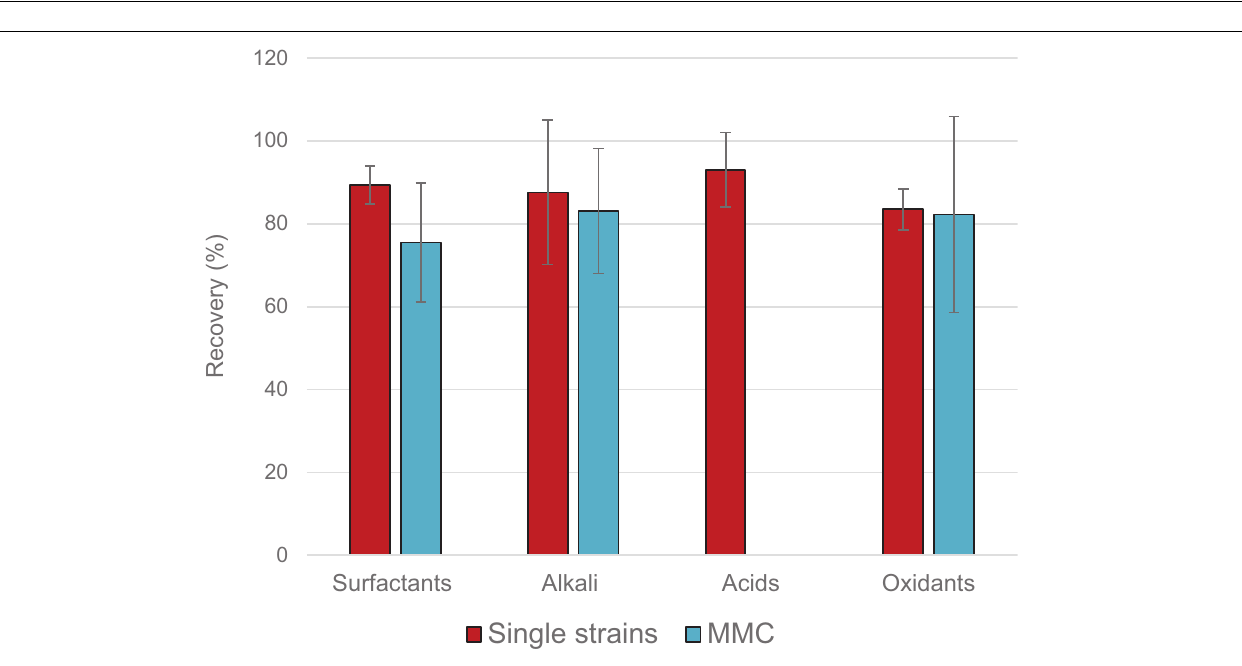
FIGURE 5 | Mean recovery (%) of PHA through cellular lysis (with surfactants, alkali, acids, and oxidants) from single strains or MMC.